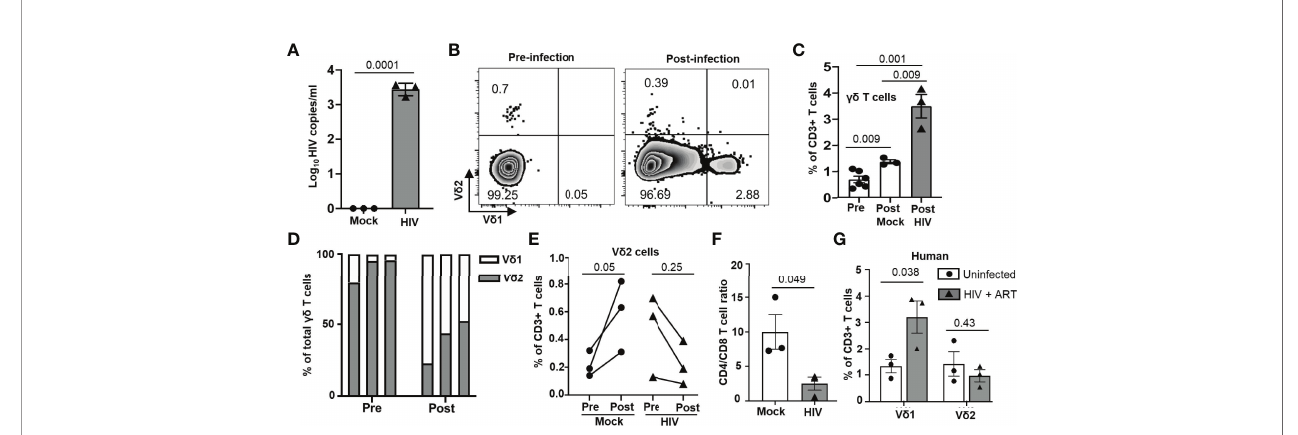
FIGURE 3 | Peripheral blood gd T cell number is altered in HIV-infected BLT huMice and humans. (A) HIV-1 replication (HIV RNA genome copies per ml) in the blood following HIV NL4-3 inoculation at 1X 10 5 IU per mouse measured by qPCR (n = 3 biological replicates per group). (B) Representative fl ow plot showing the change in frequency of peripheral blood gd T cell subsets before and after HIV infection. (C) Frequency of total gd T cells before and after HIV infection in mock